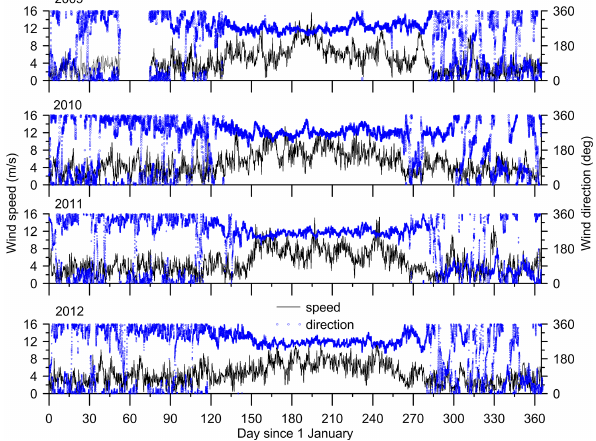
Figure 5. Time series plot of wind speed and direction at 12.5 ◦ N 72.5 ◦ E during 2009, 2010, 2011 and